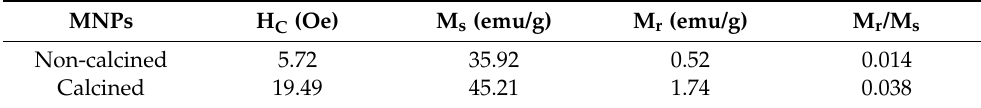
Figure 4. Hysteresis cycle of non-calcined (black) and calcined (red) Mg 0.75 Ca 0.25 Fe 2 O 4 nanoparticles. Inset: Enlargement of M–H curve in the low field region. Table 2. Results of SQUID analysis at 300 K: Coercivity (H C ), saturation magnetization (M s ), remnant magnetization (M r ) and squareness value (M r /M s ) for non-calcined and calcined Mg 0.75 Ca 0.25 Fe 2 O 4